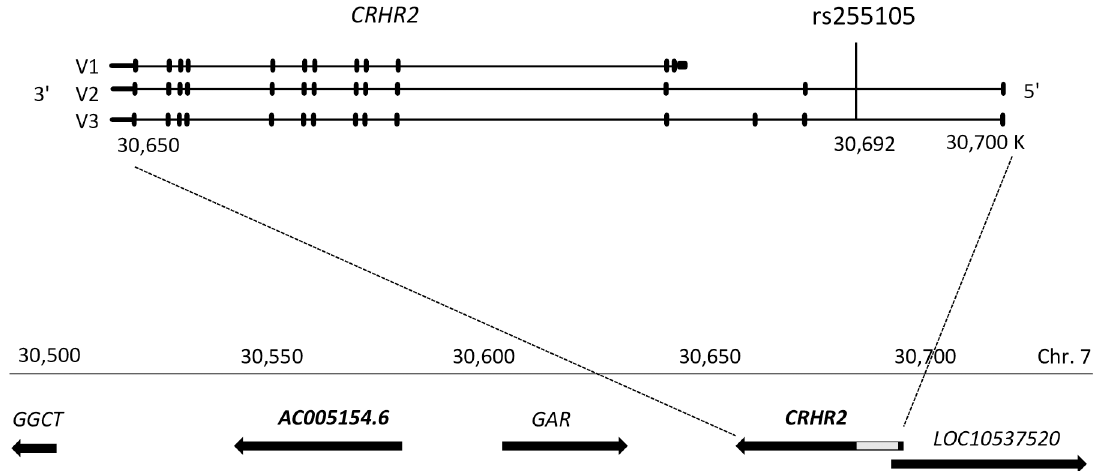
Fig 3. Genomic context of SNP CRHR2 SNP rs255015. The genomic region spanning the AC005154 . 6 and CRHR2 genes. The main CRHR2 transcripts (V1-V3) are